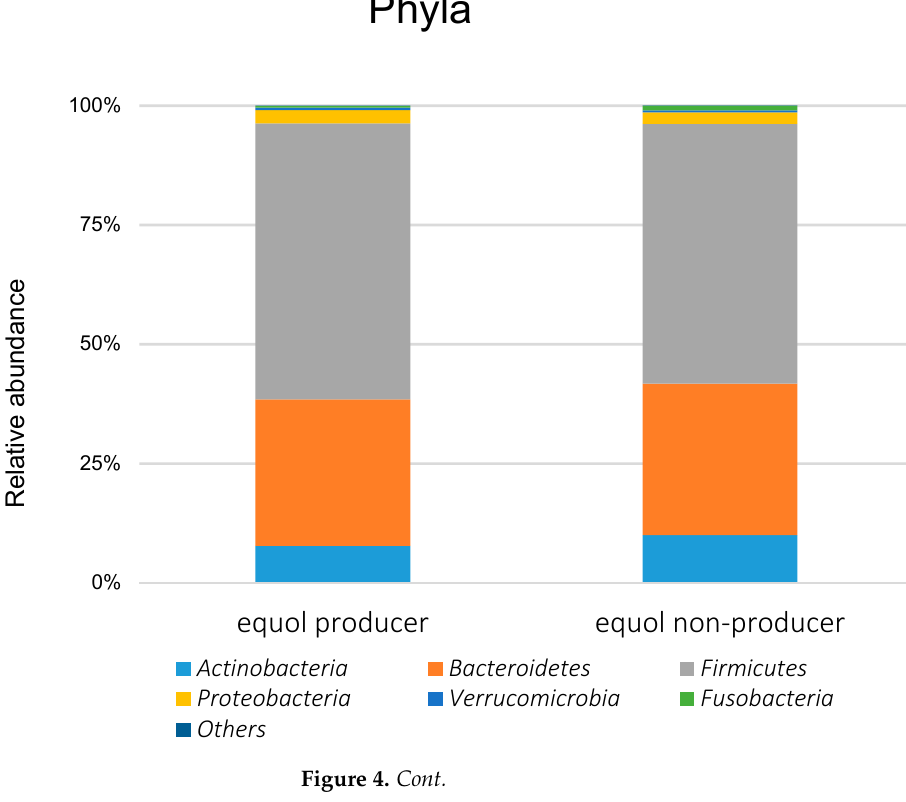
Figure 3. Principal component analysis between the equol producers and non ‐ producers. Nutrients 2019 , 11 , 433